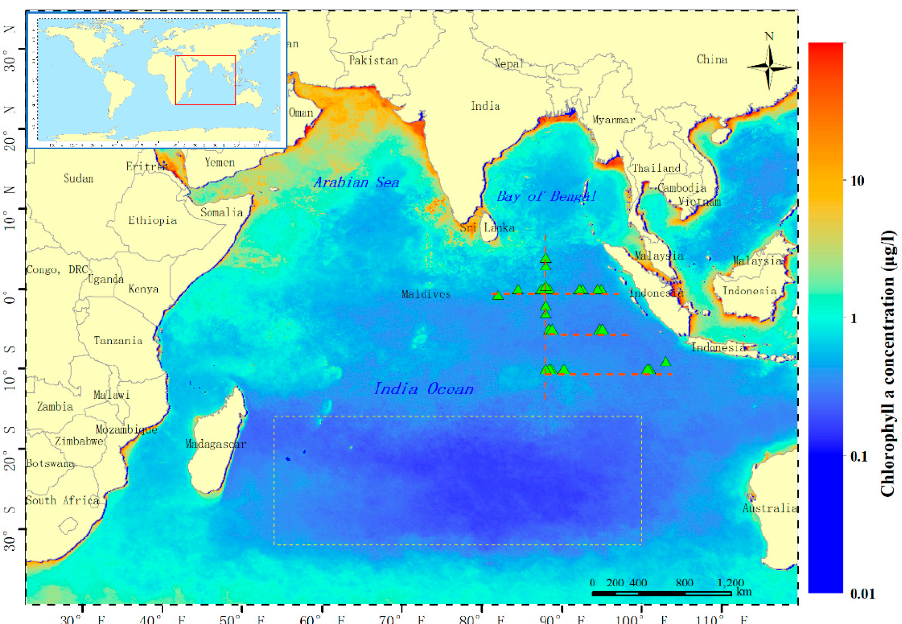
Figure 1. Study area and in situ R rs ( λ ) measurement stations (green triangles) along four transects of 0 ◦ , 5 ◦ S, 10 ◦ S, and 88 ◦ E (red dashed lines). Annual average of the global chlorophyll a concentration from Moderate Resolution Imaging Spectroradiometer (MODIS)-Aqua in 2016 is overlaid on the map. The dotted rectangle outlines the oligotrophic gyre in the south Indian Ocean characterized by the extremely low chlorophyll a concentration (Chla) (typically ≤ 0.1 mg/m 3 ).